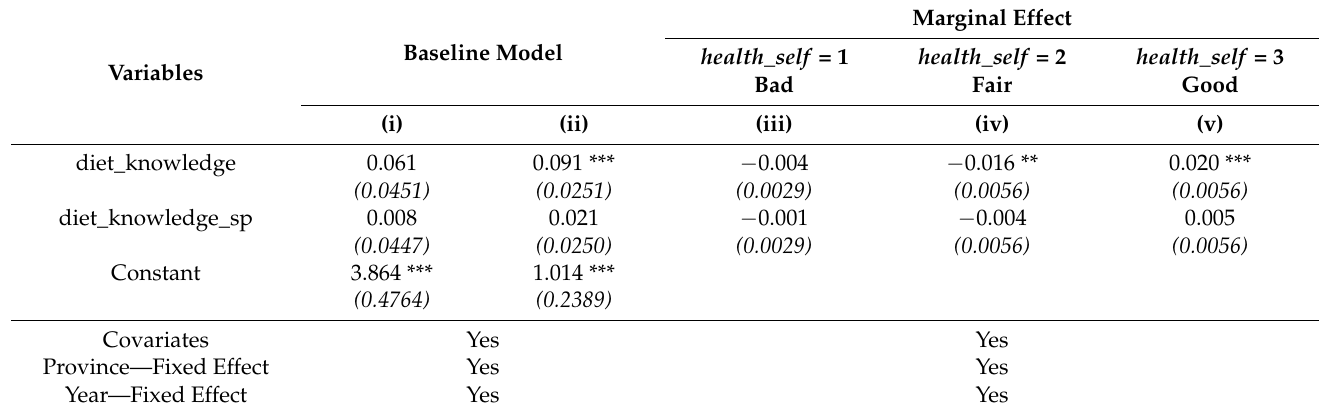
Table 5. Estimation results of the effect of the husband’s dietary knowledge on the wife’s health based on the generalized ordinal logit